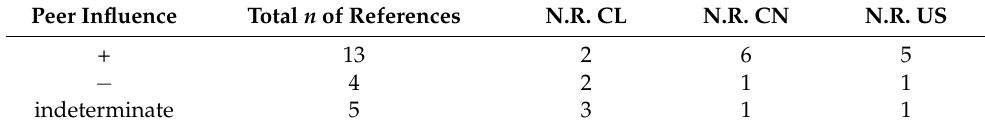
Table 4. Reference frequency of peer influence over children vegetable